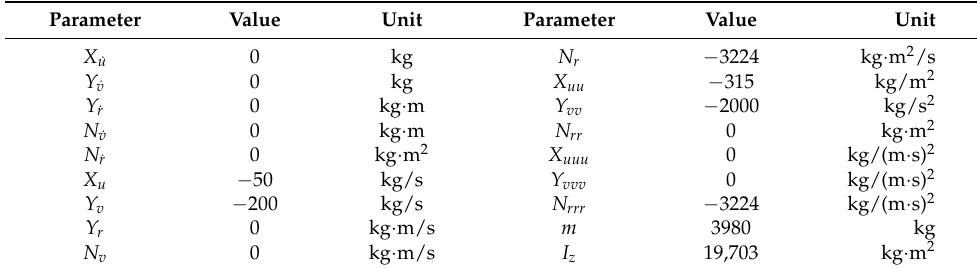
Figure 9. Block diagram of the dynamic obstacle avoidance system. Table 1. Viknes830 vessel parameters [16].